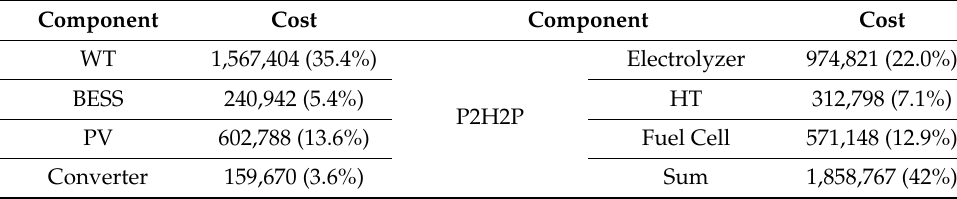
Table 15. Cost structure of topology_C by components (unit: USD).